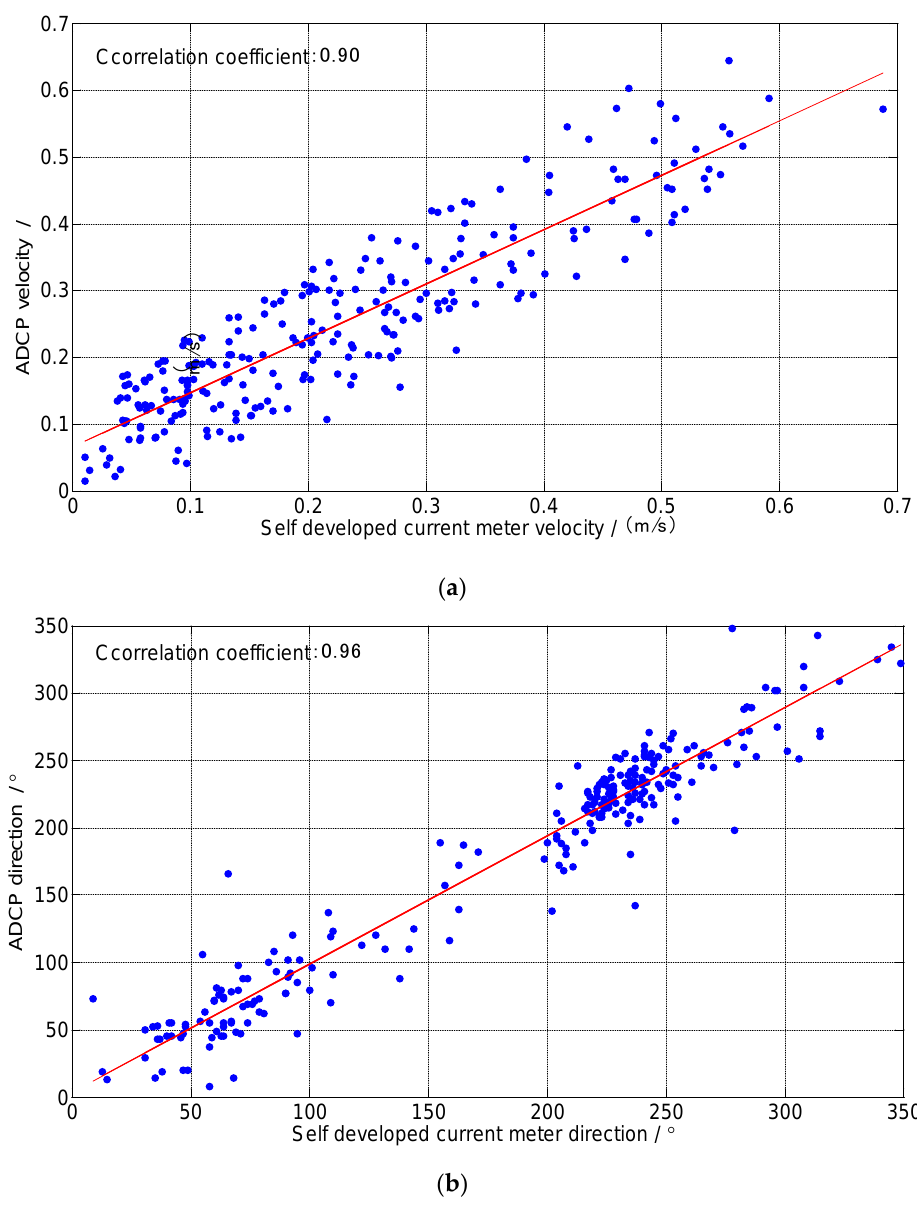
Figure 15. Correlation of the velocity and direction datum between ECM and Nortek ADCP. ( a ) Current velocity. ( b ) Current direction.